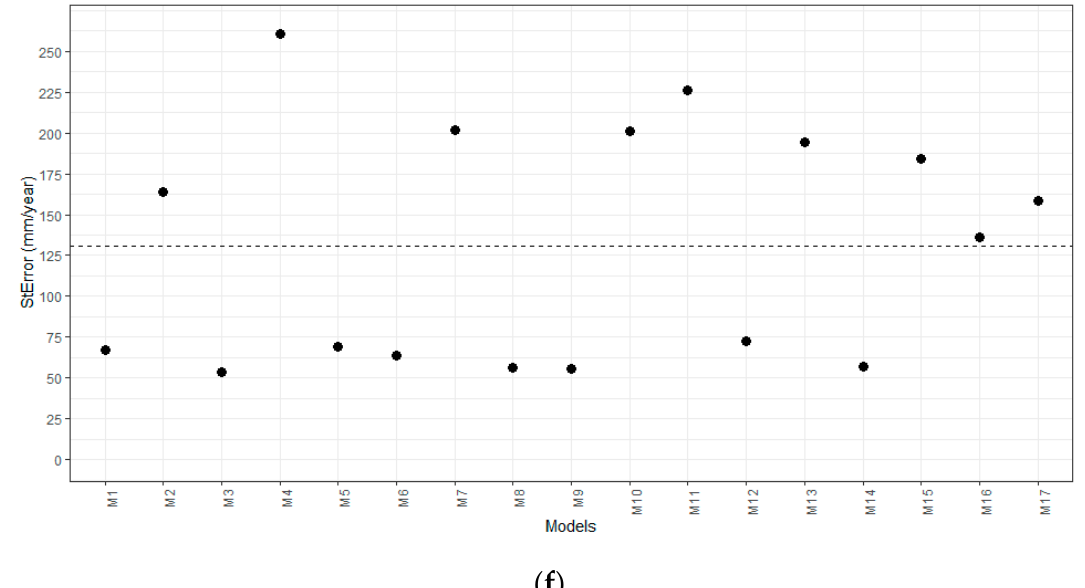
Figure 4. Comparison of results from individual CORDEX models output with respect to observed data over the period of 1986 to 2005 ( a ) Bias in basin mean annual rainfall ( b ) Bias in annual rainfall ( c ) Monthly rainfall pattern ( d ) spatial rainfall pattern correlation (r), ( e ) RMSE and ( f ) StError.